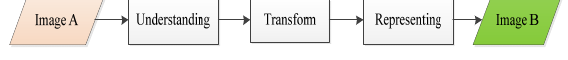
Figure 1. Remote sensing image translation